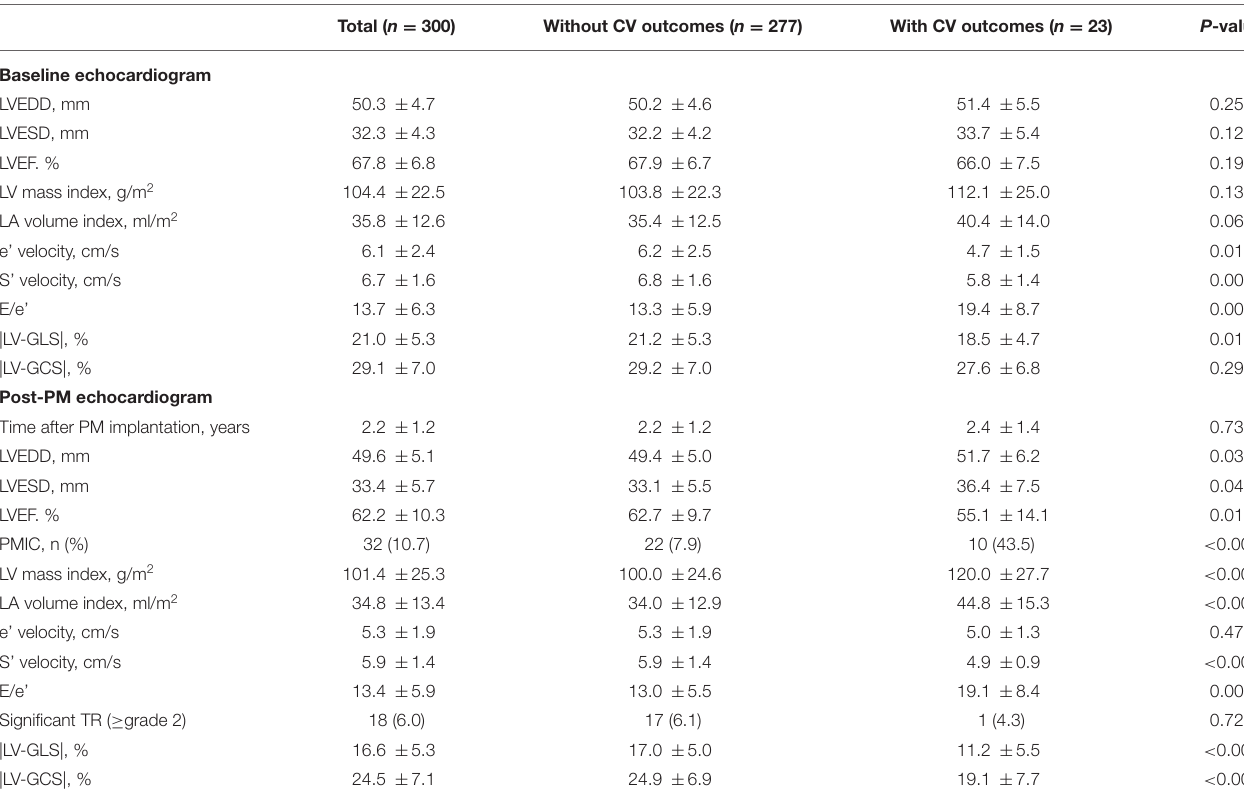
TABLE 2 | Echocardiographic